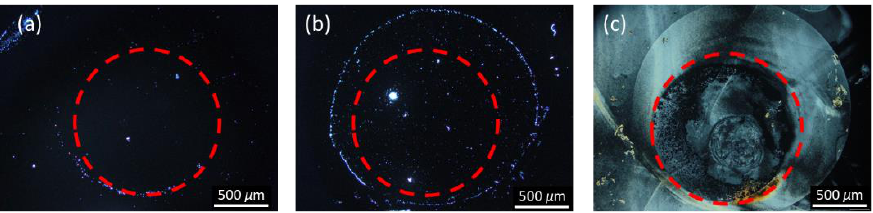
Figure 8. Polarized optical textures of spin-coated E7 films in the presence of the CA125 protein. The nematic LC E7 was spin-coated on DMOAP-coated substrates immobilized with 10 − 7 g/mL anti-CA125 antibody and reacted with CA125 at concentrations of ( a ) 10 − 6 , ( b ) 10 − 5 , and ( c ) 10 − 4 g/mL. Each red dashed circle represents the area within which the anti-CA125 antibody was immobilized. Scale bar, 500 μ m.